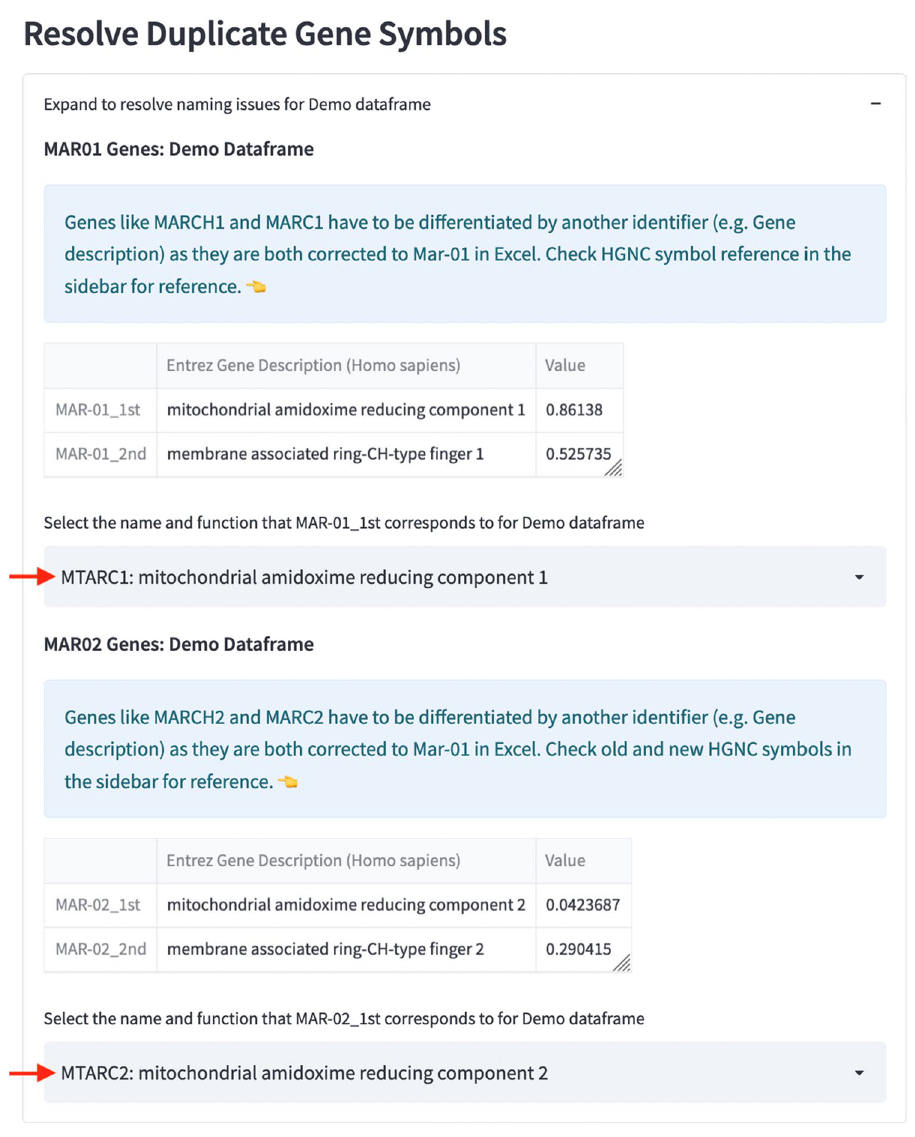
Figure 3. Gene Updater dashboard which is used to resolve duplicate gene symbols. Red arrows indicate the dropdown widgets that allows users to assign the correct gene name for Mar-01 and